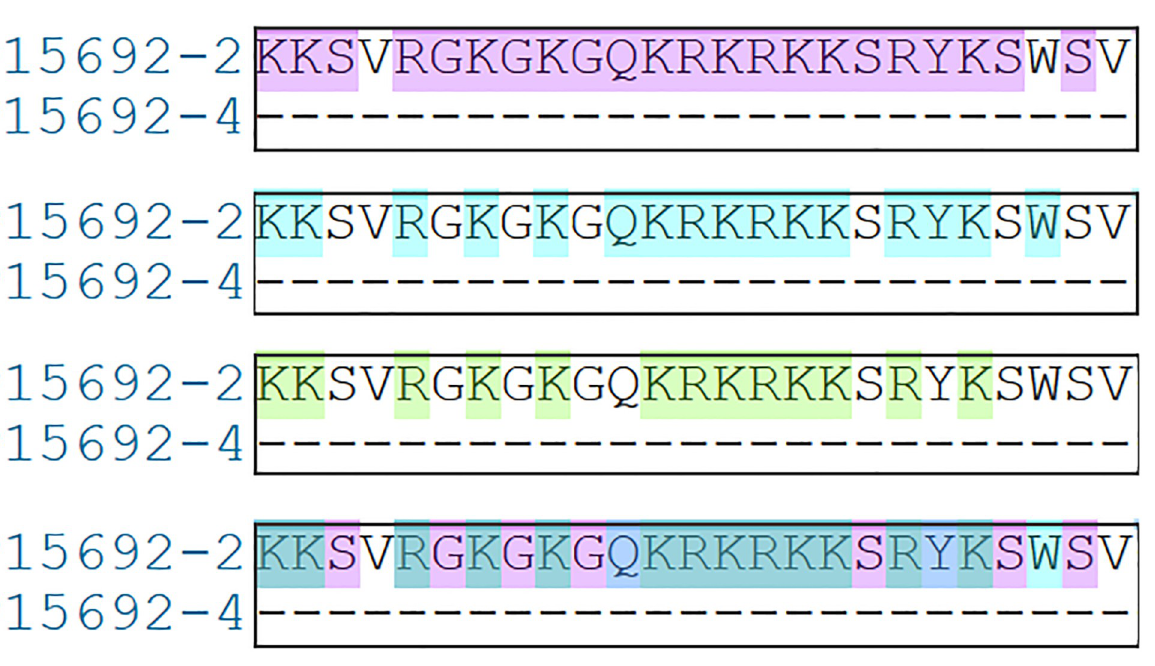
Fig 9. Focus on the 25 specific amino acids of VEGF 189 versus VEGF 165